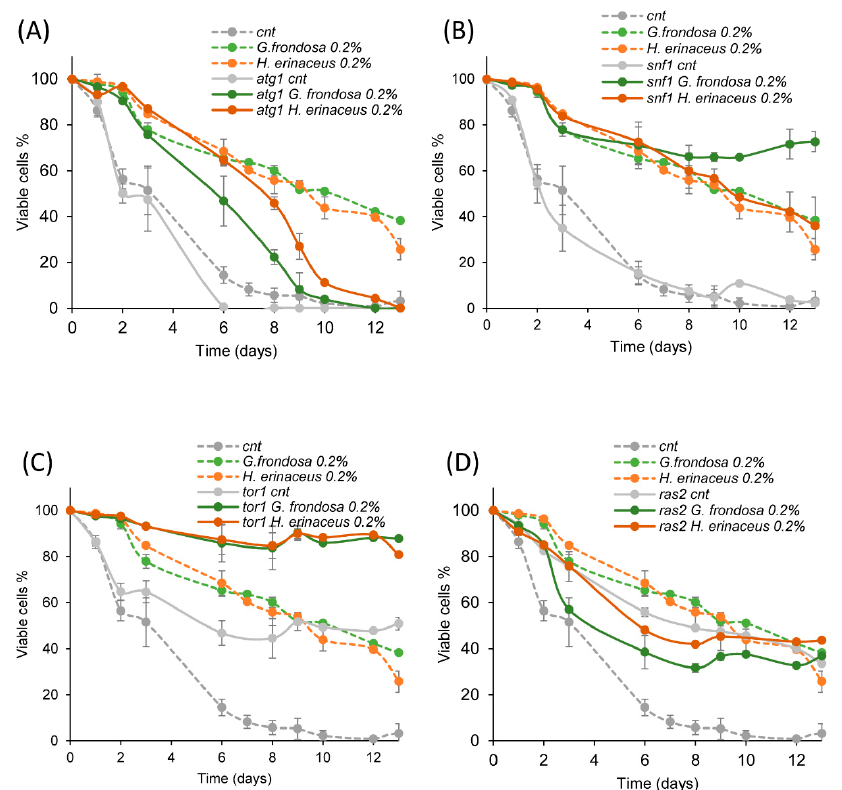
Figure 3. Ras pathway is required to extend yeast lifespan upon fungal treatment. ( A – D ) CLS of wt (cnt) and ( A ) atg1 ∆ , ( B ) snf1 ∆ , ( C ) tor1 ∆ , ( D ) ras2 ∆ cells, grown in minimal medium containing 2% glucose in the absence or presence of 0.2% G. frondosa or H. erinaceus extracts. Curves of wt untreated cells (cnt) and treated with the extracts were repeated in ( A – D ) (dashed lines).